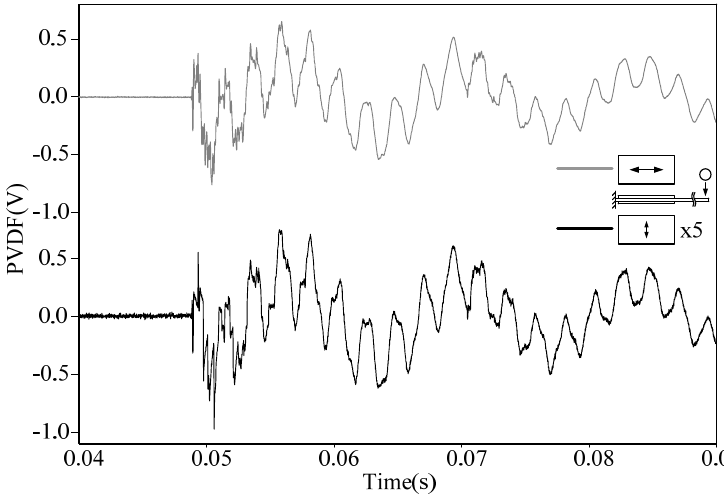
Figure 6. Measurement results of PVDF-U and PVDF-B with magnification.